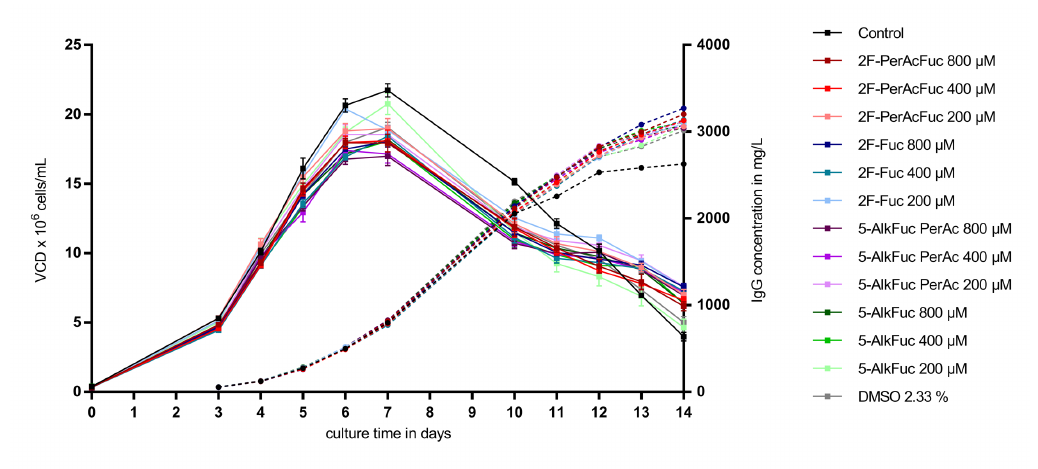
Figure 2. Viable cell density (VCD) and titer of Chinese hamster ovary (CHO) cells treated with fucose analogues. Four biological replicates were performed for each condition. The VCD is visualized as squares with a solid line and similar colors were used for the titer indicated with circles and a dashed line. Data are expressed as mean values ± standard error of the mean (SEM).